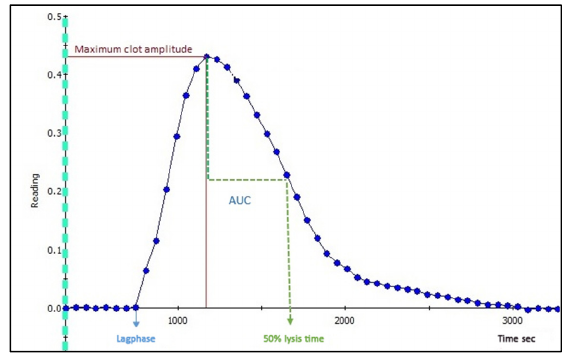
Figure 2. The clot-lysis curve and derived parameters.